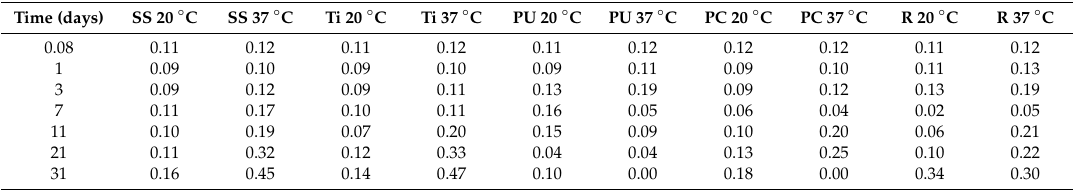
Table 4. A21 desamido insulin formed over time at 20 °C and 37 °C as a percentage of the total insulin peak area for method A.